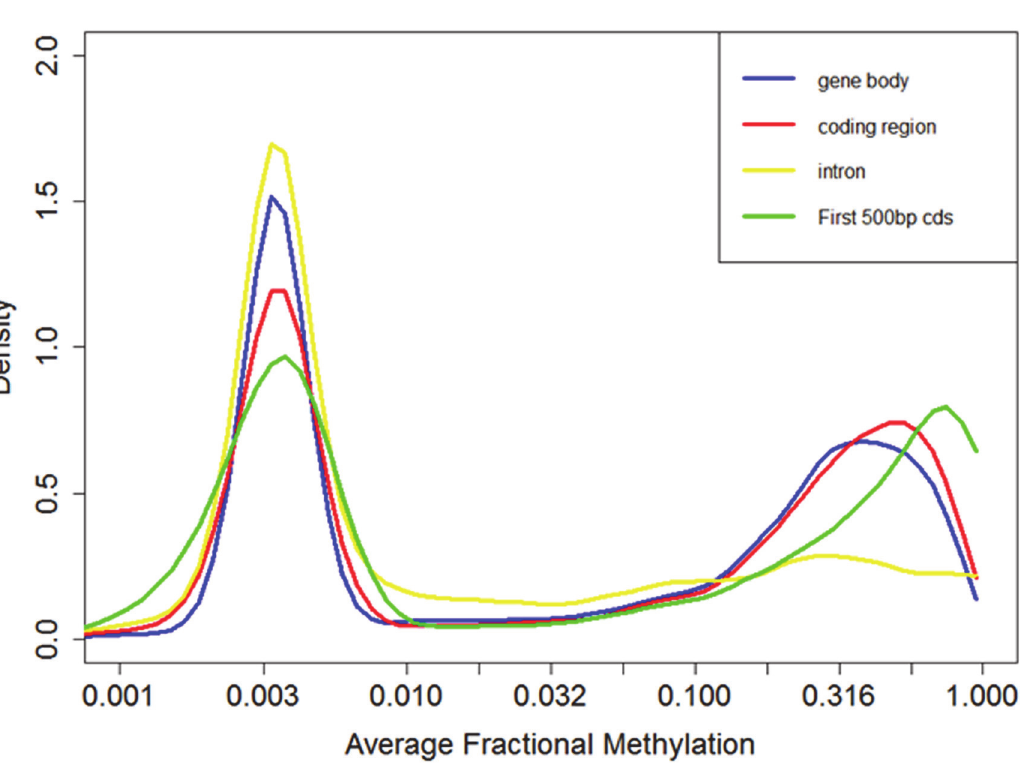
Fig 4. Distribution of fractional methylation levels of genes. Distribution of DNA methylation levels (measured by fractional methylation levels) of genes. The X-axis is drawn in a log-transformed scale with the actual methylation levels indicated. A total of 11,063 genes are grouped into 100 equal size parts. The genes clearly divide into two groups, one with sparse DNA methylation (peak at around 0.03) and the other with relatively high DNA methylation (peak at around 0.6).